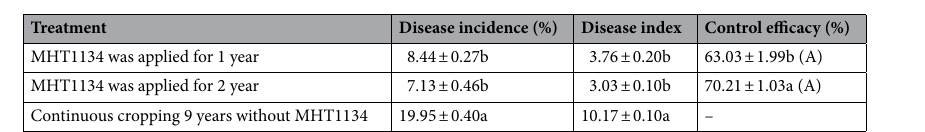
Table 1. Control effects of strain MHT1134 on Fusarium wilt in continuous pepper cropping fields. The data are mean ± SD. The different capital and lowercase letters in the same column indicate significant different at P < 0.1 and P < 0.05 level by Duncan’s new multiple range